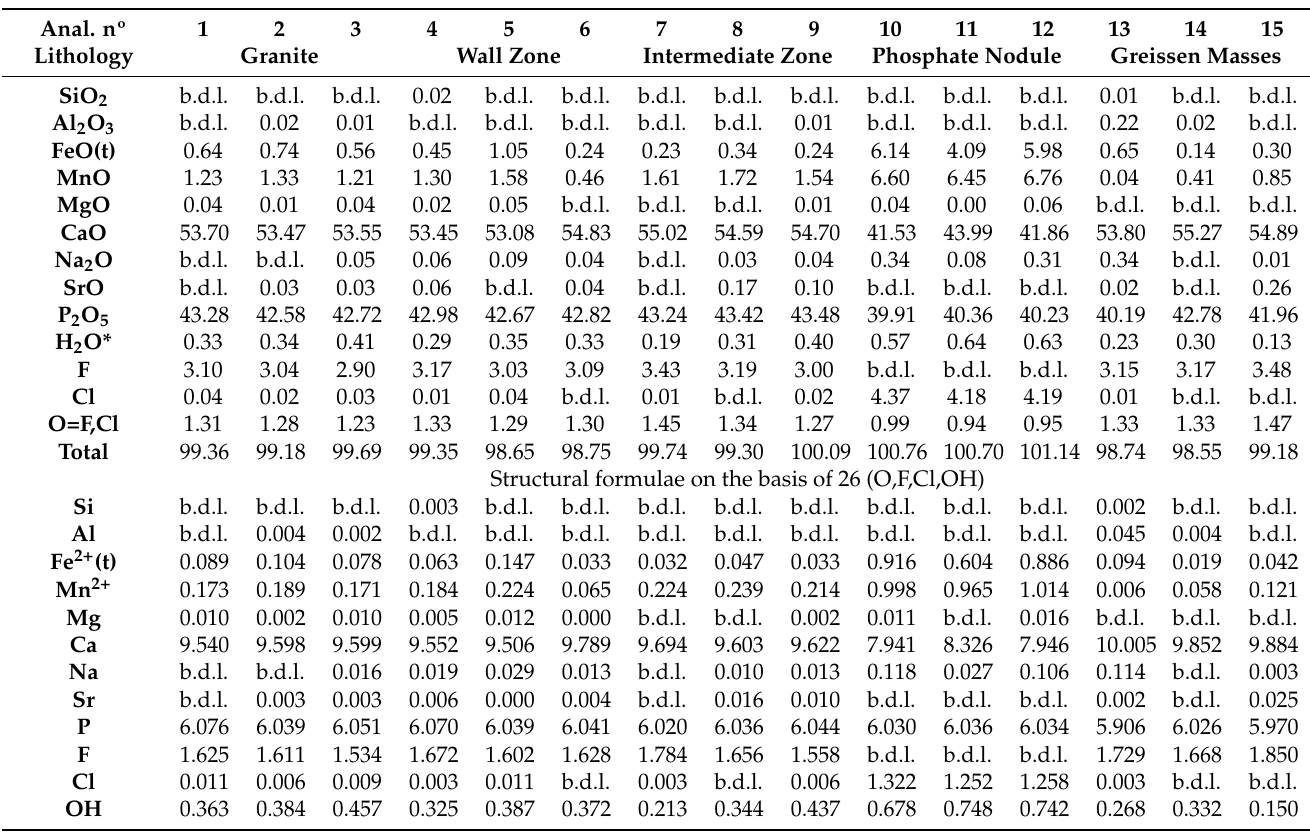
Table 4. Representative microprobe analyses with major element composition (wt.%) and unit formula (a.p.f.u.) calculated on the basis of 26 (O,F,Cl,OH), H 2 O* estimated, for apatite associated with the different units distinguished in the Puentemocha pegmatite and in its hosting granite. b.d.l. below detection limit.—not